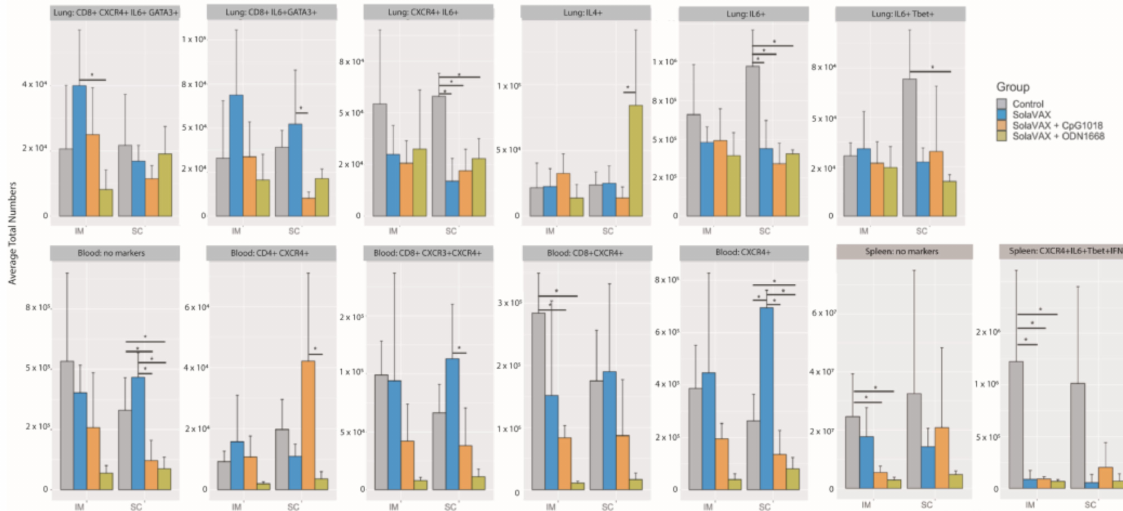
Figure 6. Statistically significant flow cytometry populations within intramuscular and subcutaneously vaccinated groups. The bar plots show the statistically significant populations identified through cyto-feature engineering for each organ. The x -axis shows the eight groups studied. The average total numbers of cells for each group were calculated and shown. The population names listed at the top of each small plot indicates the flow cytometry markers that are positive in the population. Note that these populations are negative for all of the other markers in the panel. * p <